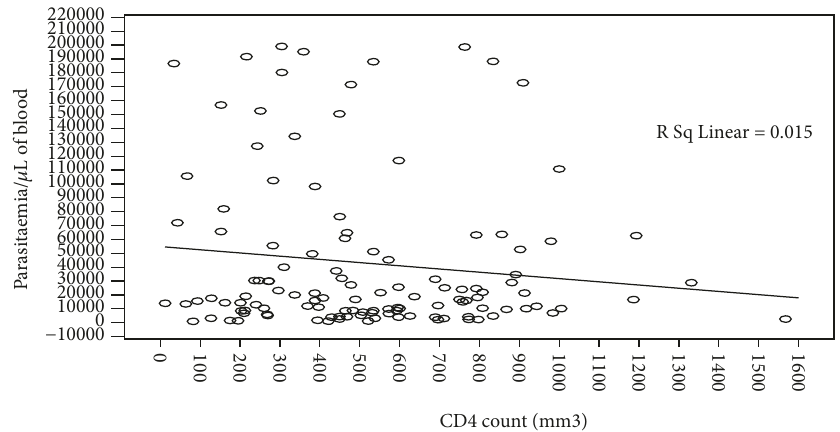
Figure 3: Density of malaria parasites relative to CD4 T-cells count on day 0 .